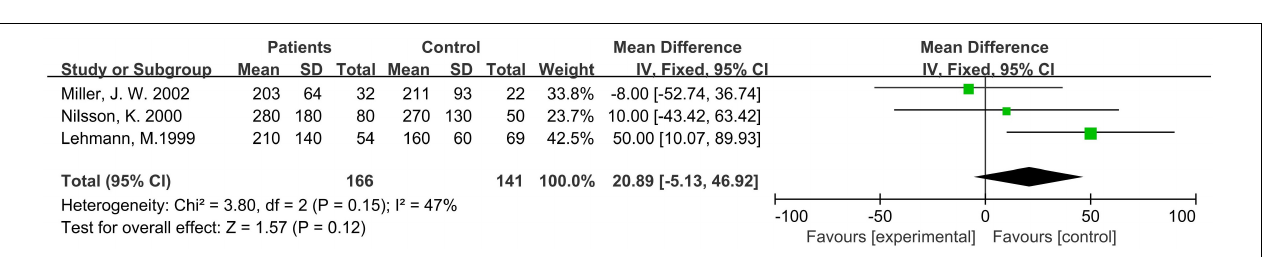
Frontiers in Pediatrics |